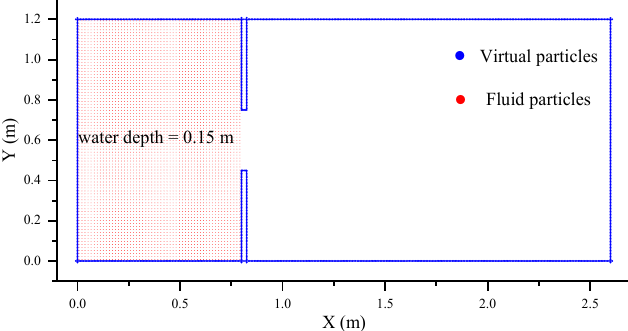
Figure 6. 2-D dry bed dam break with particle splitting (DBDB) case setup.